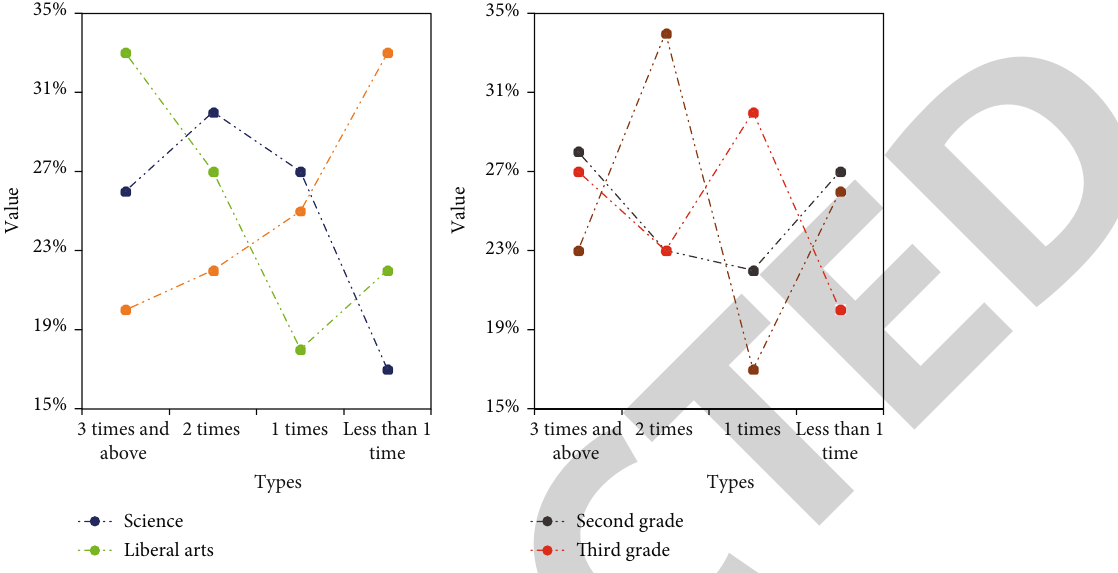
Figure 6: Exercise frequency of students in di ff erent disciplines and di ff erent